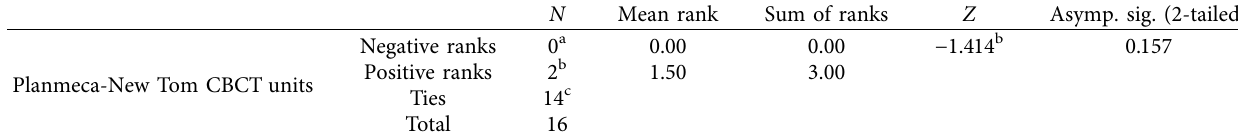
Table 2: Comparison of marginal leakage scores between Planmeca and New Tom CBCT units. N Asymp. sig. (2-tailed)